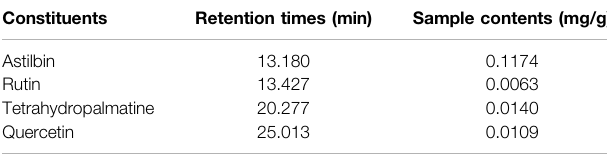
TABLE 2| Herbal retention times and samplecontentsofcomponents in